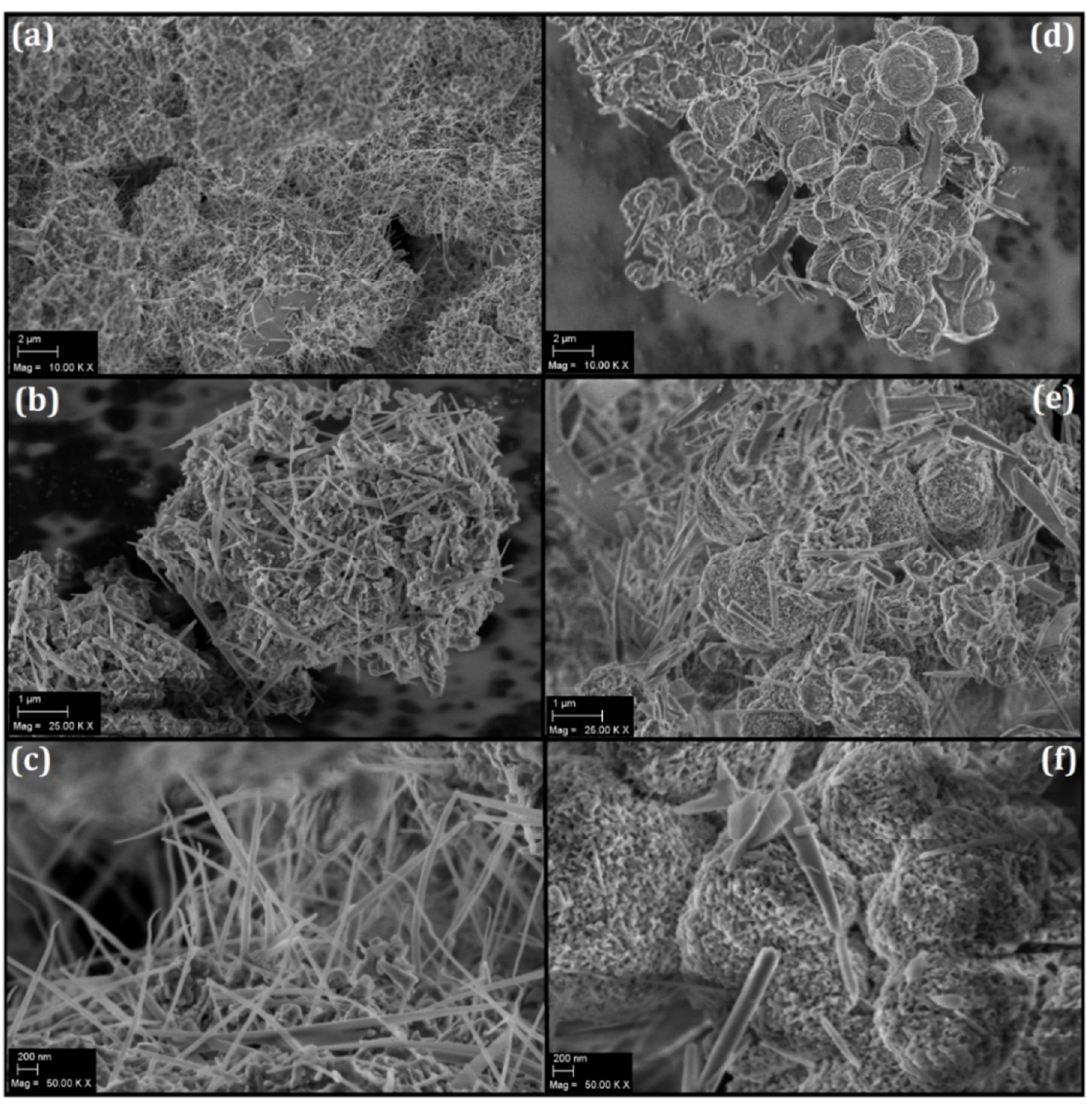
Figure 2. SEM images of ( a – c ) PPA1 HT and ( d – f ) PPA16 HT-HH